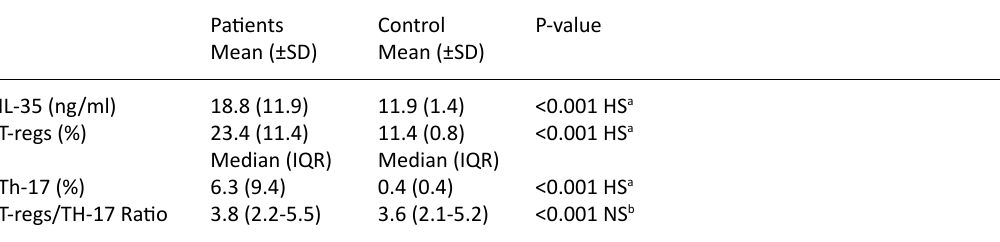
table 2. Serum IL-35 level, T-regs and Th-17 frequency and Tregs/Th-17 ratio in patients and